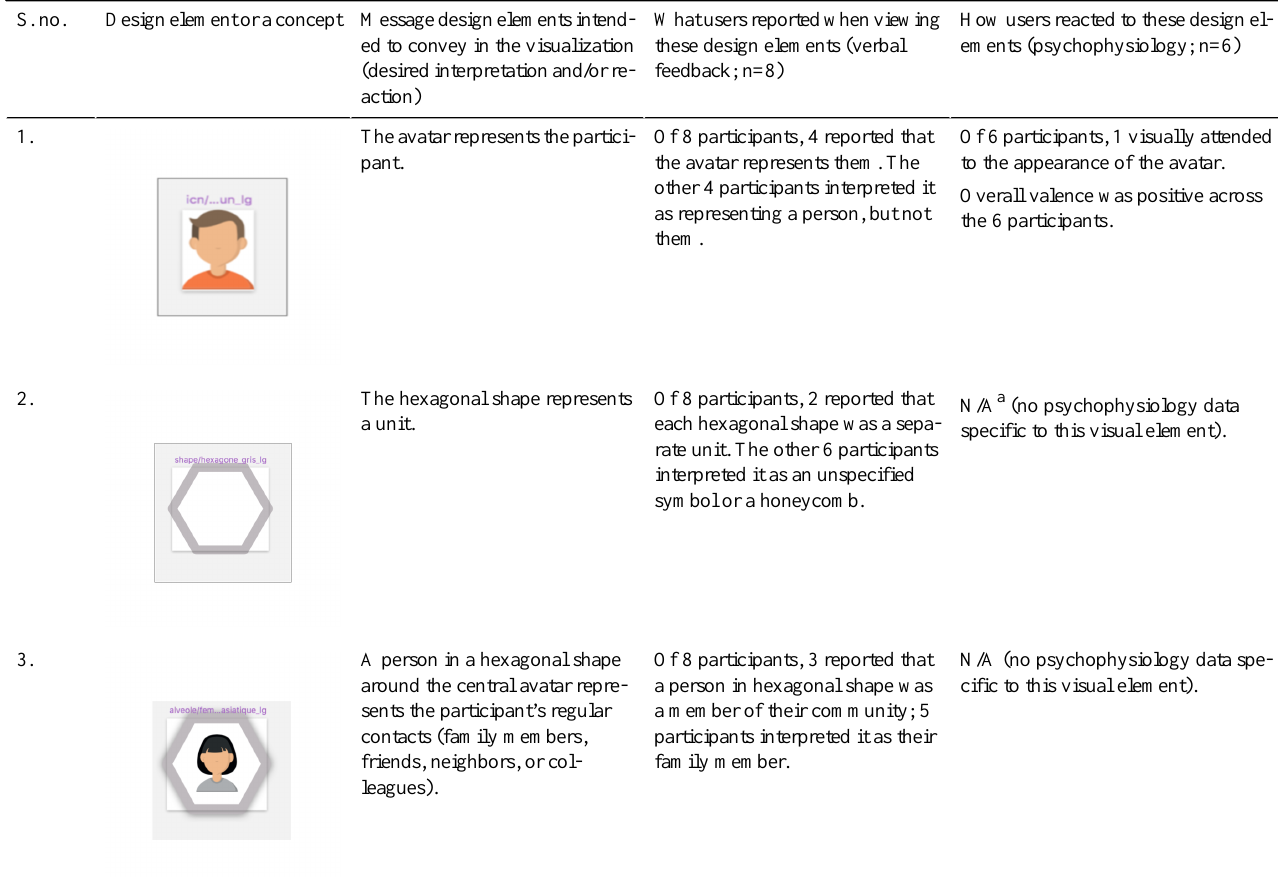
How users reacted to these design el- n=6)What users reported when viewing ements (psychophysiology; these design elements